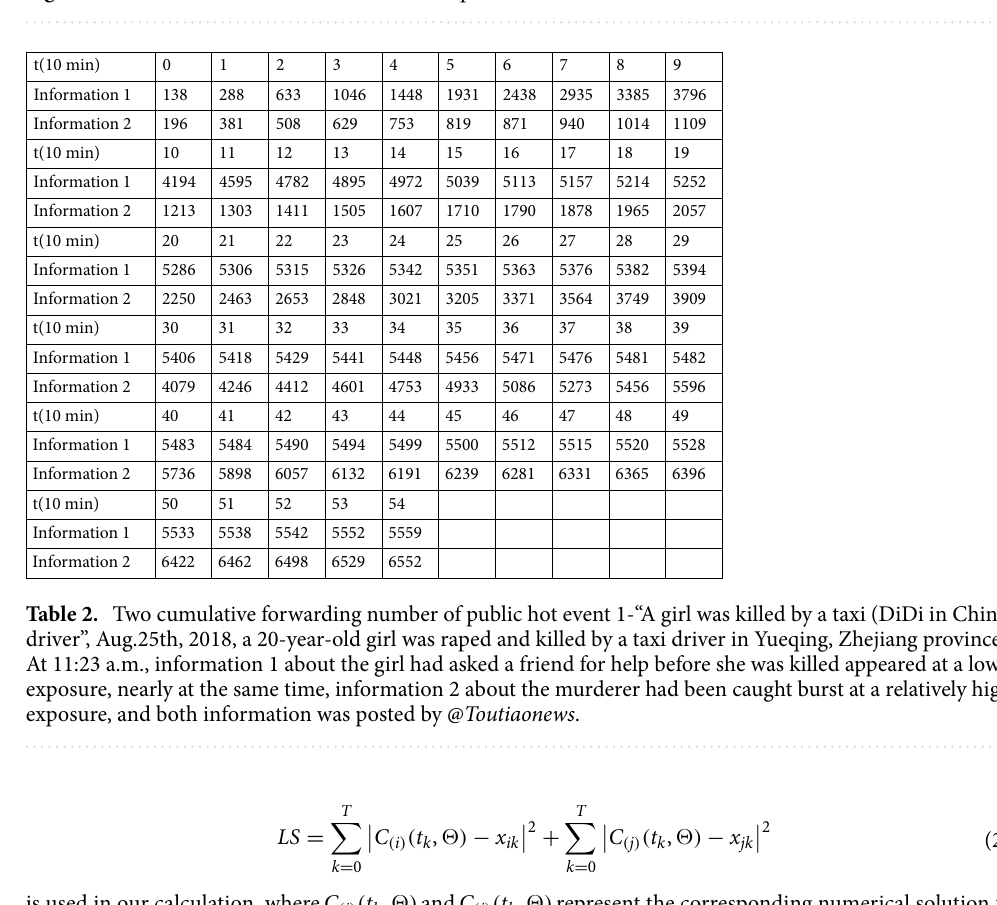
Figure 10. The source of data collection for one public hot event.